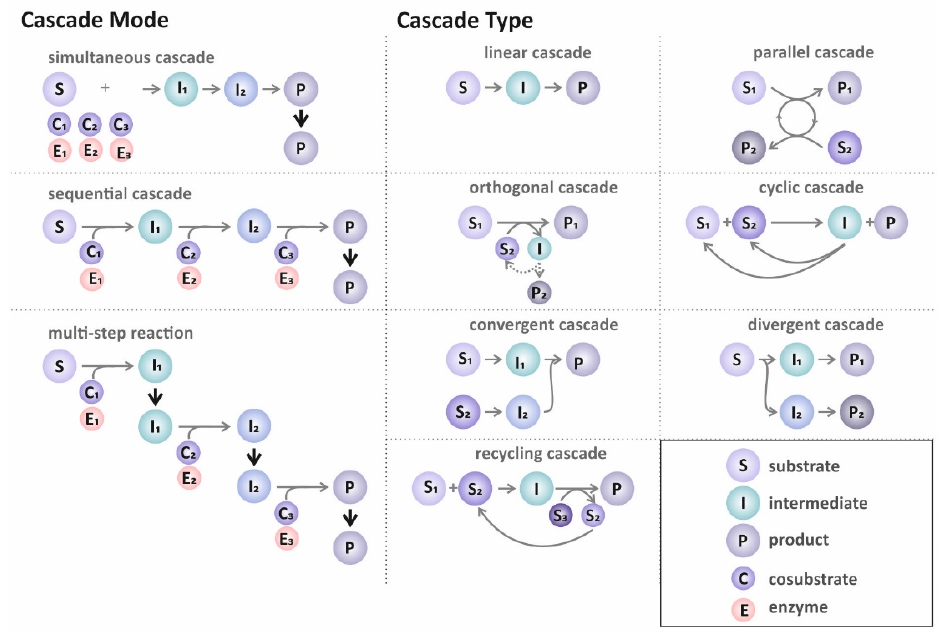
Figure 4. Cascade Mode: defines if all reaction components are added at the same time (simultaneous cascade), in a temporal manner (sequential cascade), or if more isolations are needed in between the reaction steps (multi-step reaction). Cascade Type: defines how the reaction steps are organized, and if interconnections occur between the reactions. Linear cascade—a single product is synthetized